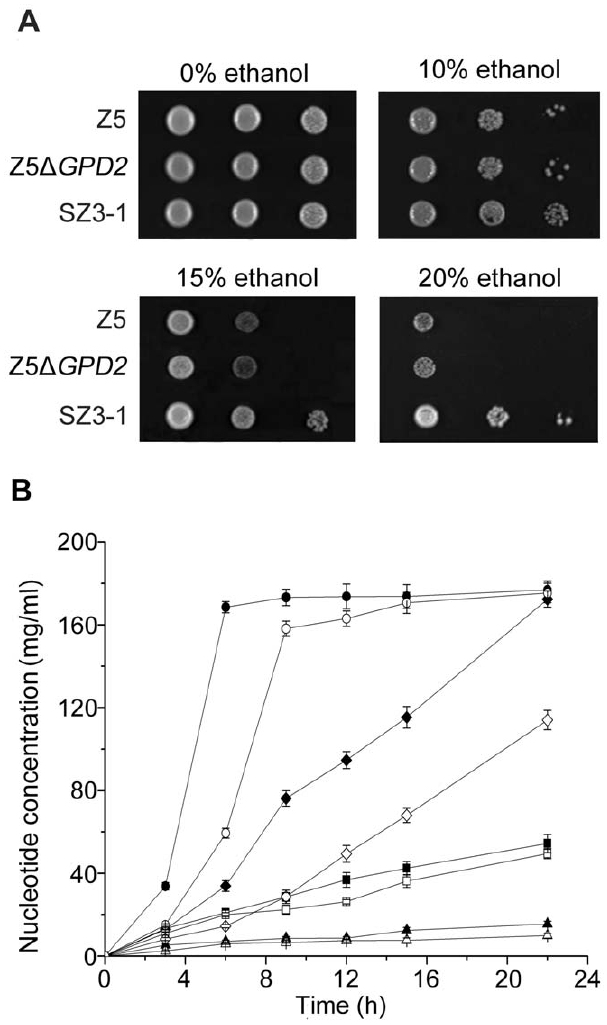
Figure 3. Determination of ethanol stress tolerance of strains Z5, Z5 D GPD2 and SZ3-1. (A) Growth of strains Z5, Z5 D GPD2 and SZ3- 1 on different concentration of ethanol. Cells were grown in the YPD liquid medium at 30 u C overnight and 10-fold serial dilutions of each sample were spotted onto the YPD medium and the YPD medium containing 10%, 15%, 20% (v/v) ethanol. Stress tolerance was calculated as the percentage of biomass formation or viable cells in stressed culture compared with that in control culture. (B) Time course of extracellular nucleotide concentration in cell suspension of strains Z5 (filled symbols) and SZ3-1 (open symbols). Yeast cells were suspended in aqueous solution with 0% (triangles), 10% (squares), 15% (diamonds), and 20% (circles) (v/v) ethanol and incubated at 30 u C. Concentration of nucleotide that leaked into the supernatant was measured every few